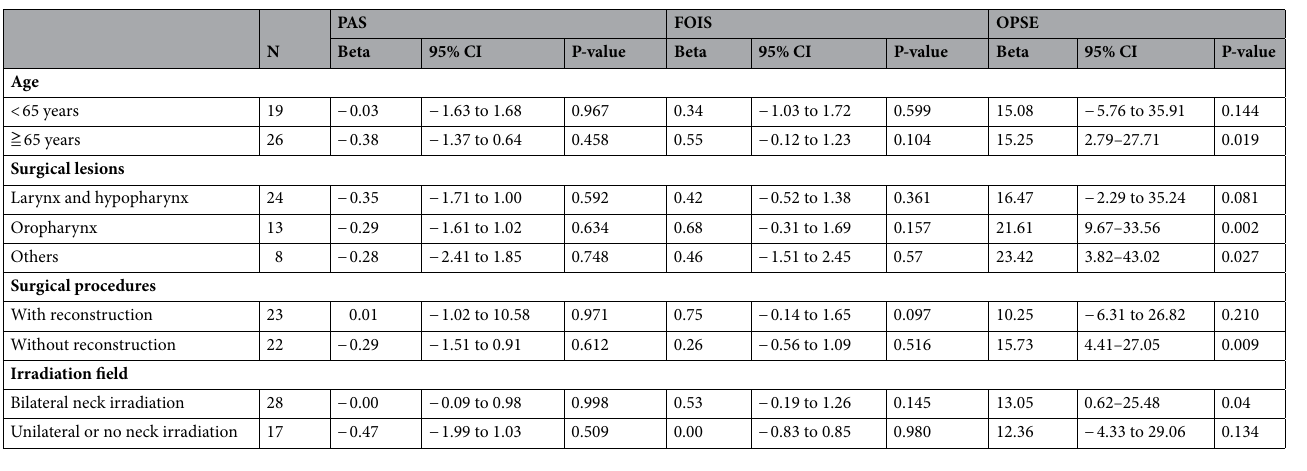
Table 6. Stratified analyses between the cross sectional area of the masseter muscle and the PAS, FOIS, and OPSE scores after surgery. N number of patients, PAS penetration aspiration scale, FOIS Functional Oral Intake Scale, OPSE oropharyngeal swallow efficiency, CI confidence